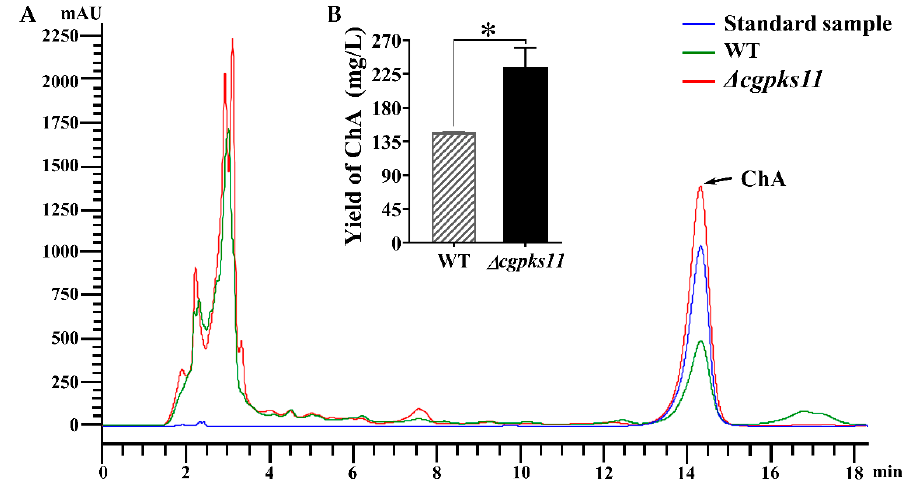
Figure 4. CgPKS11 deletion led to increased production of ChA. ( A ) HPLC analysis on the production of ChA in the WT and Δ cgpks11 . ( B ) Yields of ChA in the WT and Δ cgpks11 . Three culture replicates of each strain were used. There is significantly difference between the mutant and wild-type strains, as indicated by an asterisk ( p -value < 0.01 with t -test analysis).